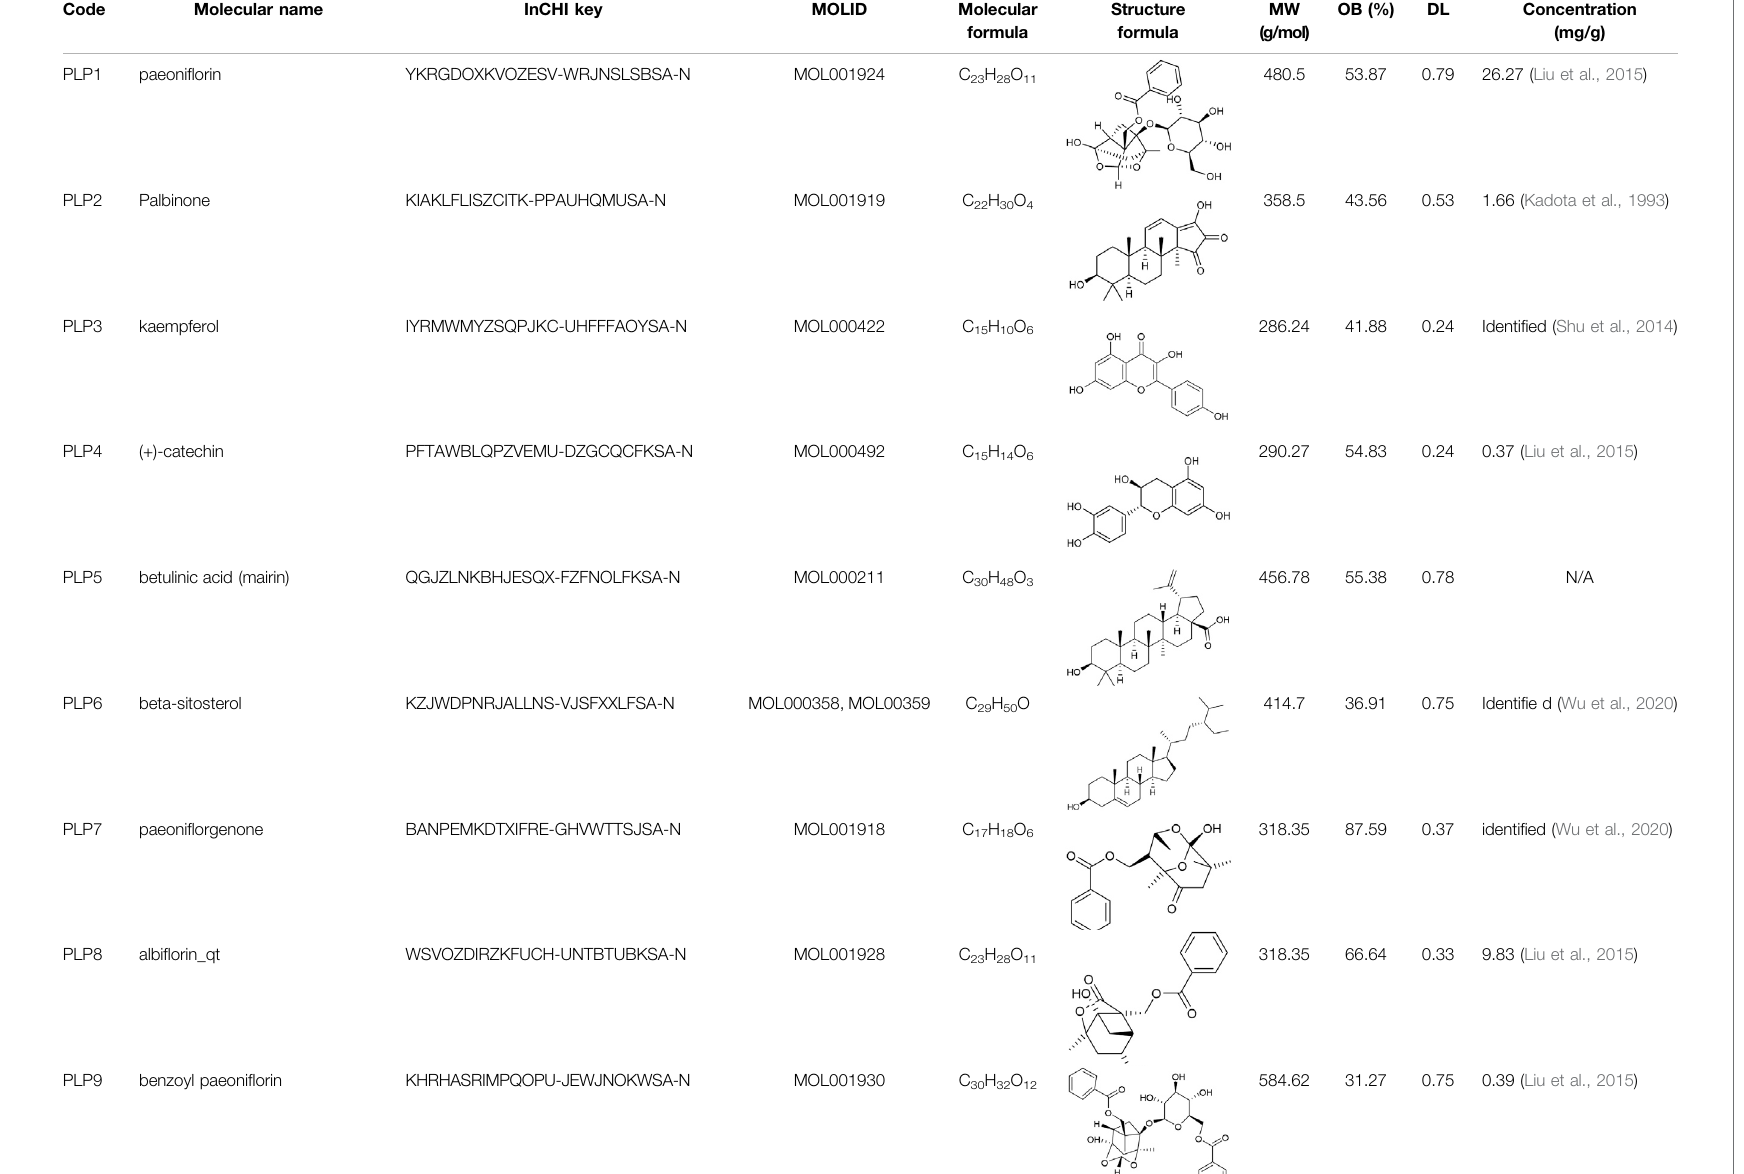
TABLE 1 | Chemical properties of Paeonia lacti fl ora Pall. active